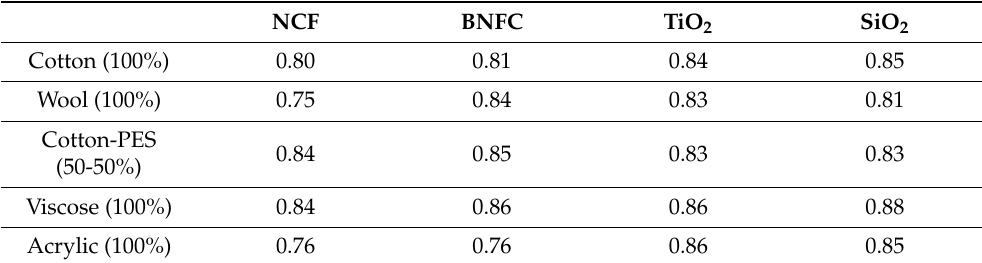
Figure 6. Compnteredarison among three acrylic fabric samples placed close to each other: coated with SiO 2 and TiO 2 bioceramic nanoparticles, and uncoated. The thermal imager captures all samples together: ( a ) apparent temperature. The temperature of each textile is at 45 °C, as measured by the thermocouple; ( b ) textile emissivity map, as calculated from the thermal image in Figure 5a. Table 3. Measured emissivity ( ε ) values of